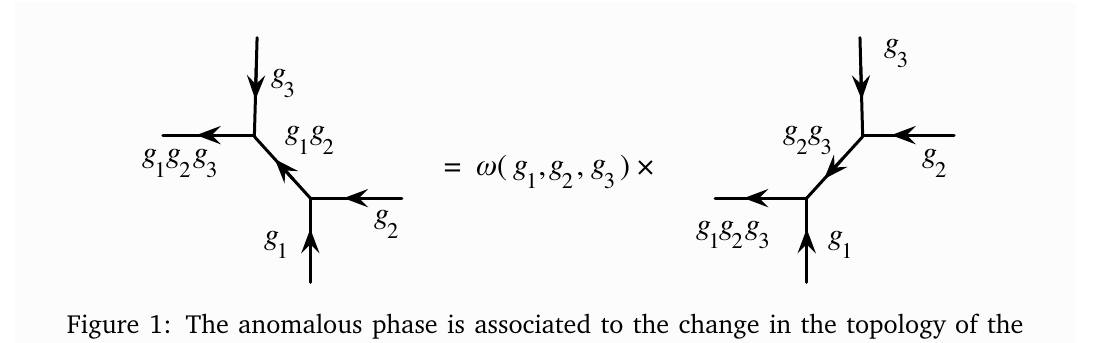
Figure 1: The anomalous phase is associated to the change in the topology of the domain walls on X implementing the G D